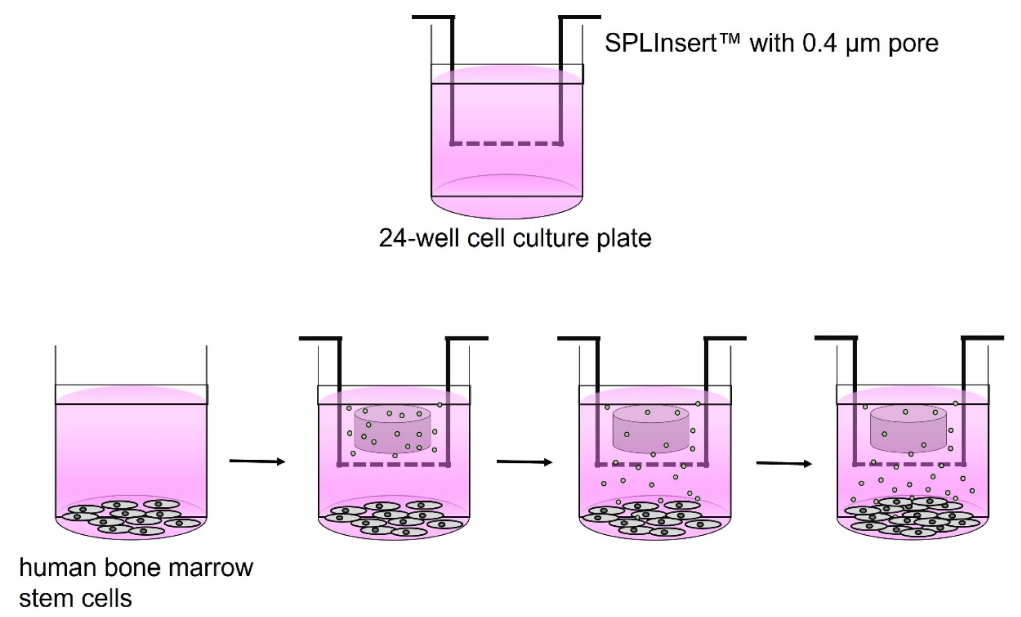
Figure 1. Experimental procedures of cell viability, cell migration, and alkaline phosphate activity